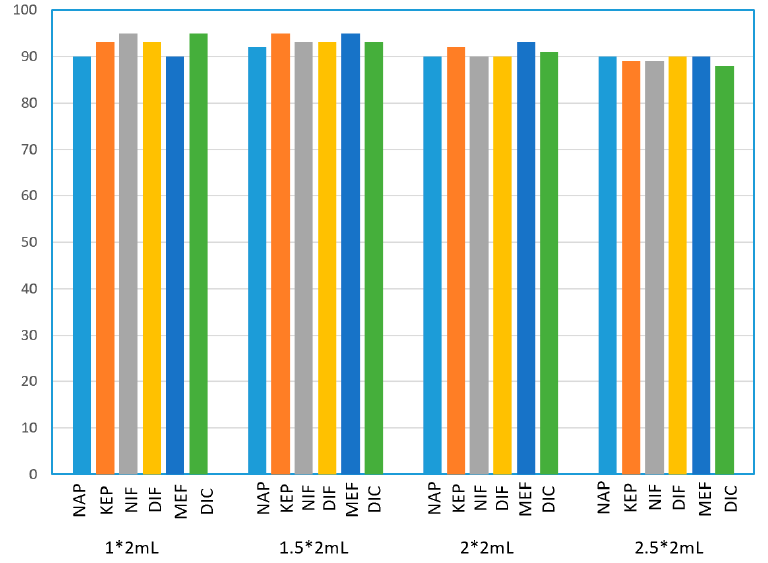
ff ects of elution volume on the recoveries (%) of selected pharmaceuticals, n = Figure 6. Effects of elution volume on the recoveries (%) of selected pharmaceuticals, n = 3. Figure 6. E